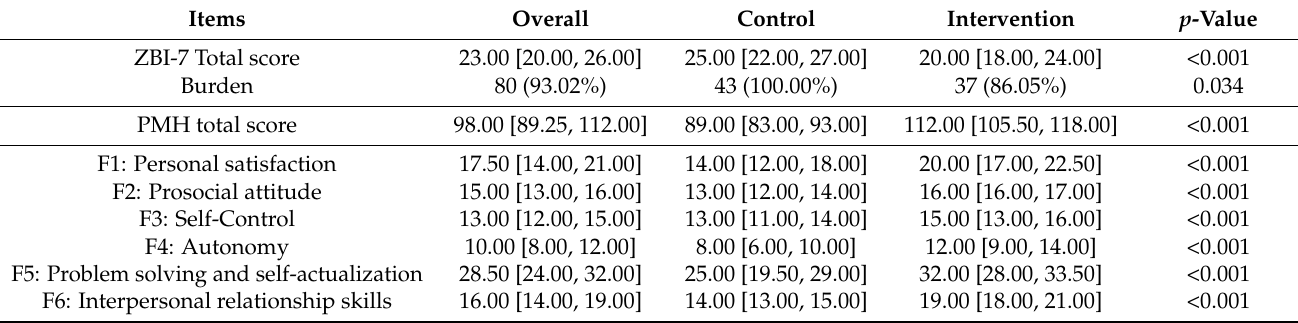
Table 3. Follow-up scores for the overall sample and for the control and intervention